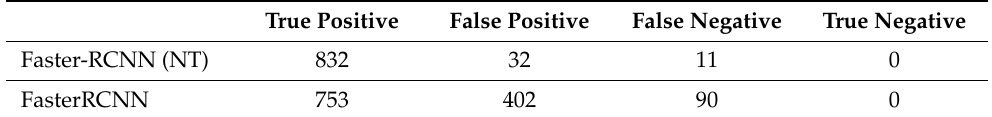
Table 2. Faster-RCNN Confusion Matrix.